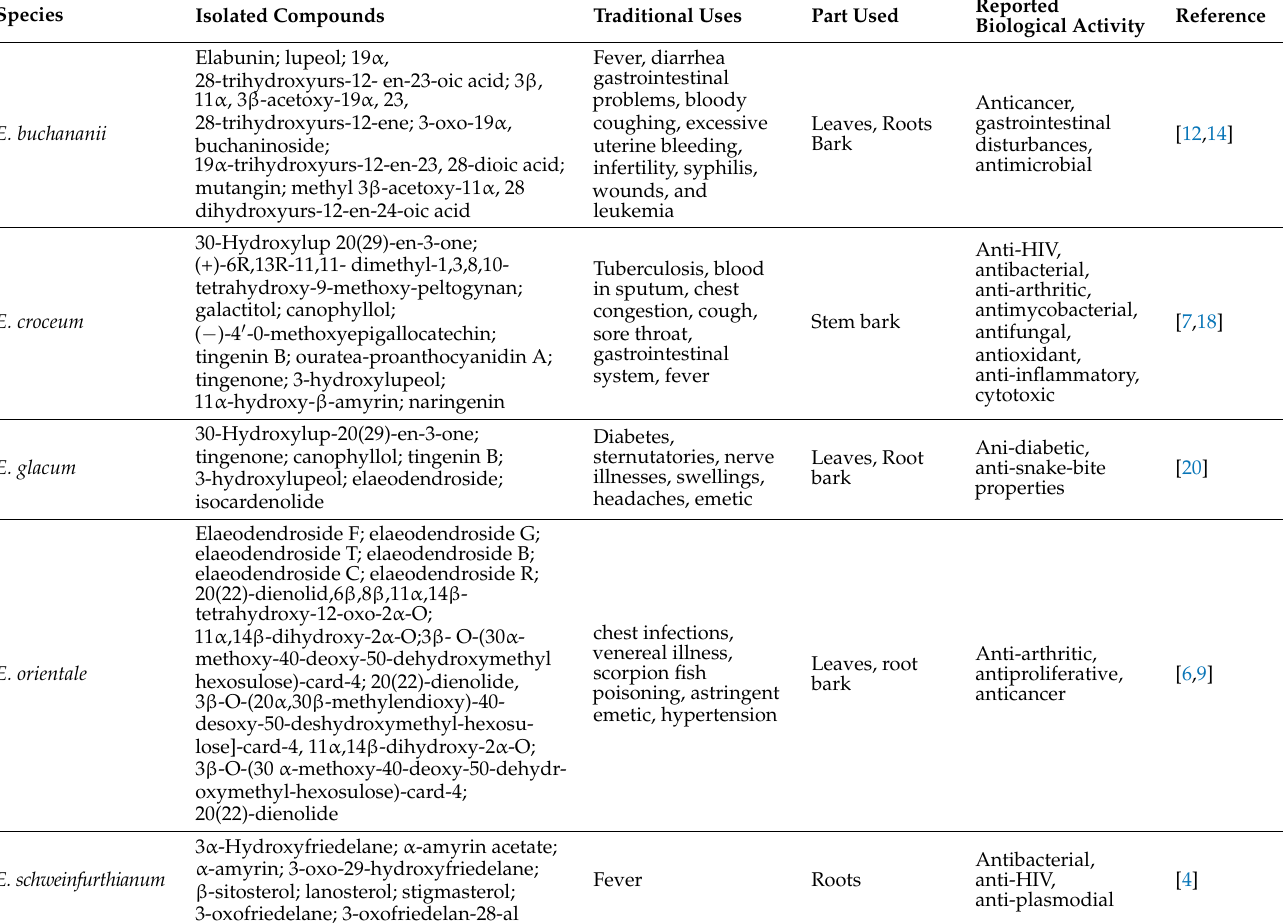
Table 1. Bioactive phytochemicals, traditional uses, part used, and biological activities of Elaeodendron